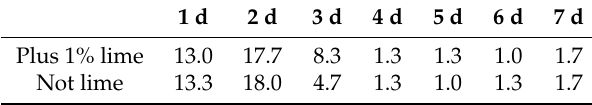
Table 11. Mass (g) loss of the mixture seven days before the room temperature regimen. 1 d